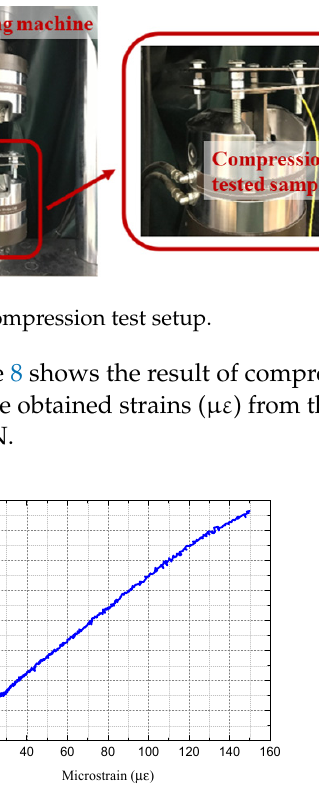
Figure 8. Results from the loading calibration test.